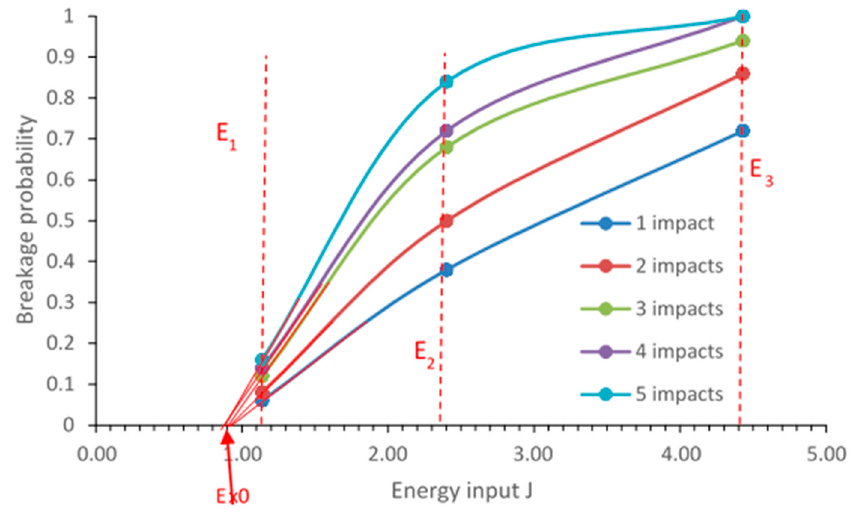
Figure A1. Determination of E x 0 applied to the dolomite sample.